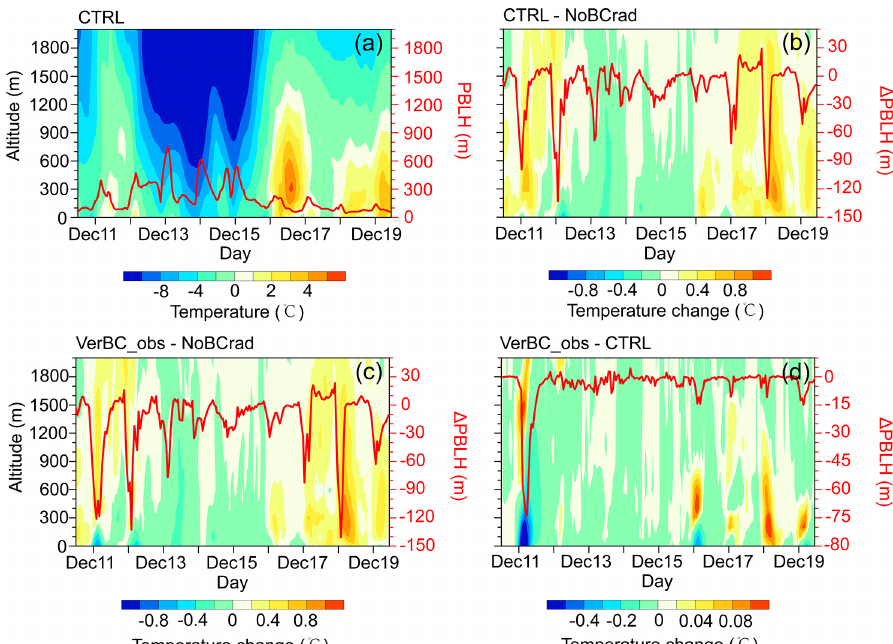
Figure 7. (a) Simulated hourly vertical profiles of temperature (contour) and PBLH (red solid line) over Beijing at local time (LT) from 11 to 19 December 2016. (b–d) Time series of changes in vertical temperature (contour) and PBLH ( (cid:49) PBLH; red solid line) induced by BC DRE with the original ( b ; CTRL minus NoBCrad) and modified vertical profiles ( c ; VerBC_obs minus NoBCrad) and the difference between the effects of the modified and original BC profiles ( d ; VerBC_obs minus CTRL) over the Beijing region from 11 to 19 December 2016.